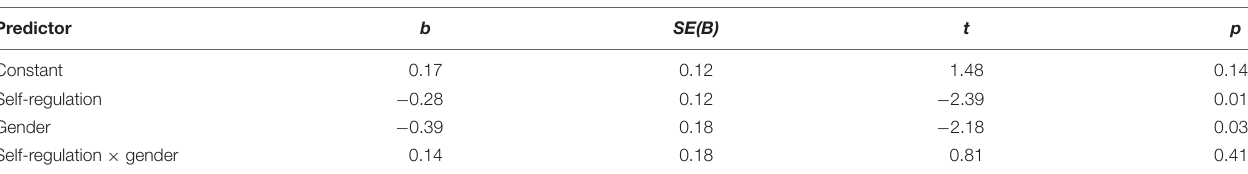
TABLE D3 | Linear model of predictors of multiplication RT.